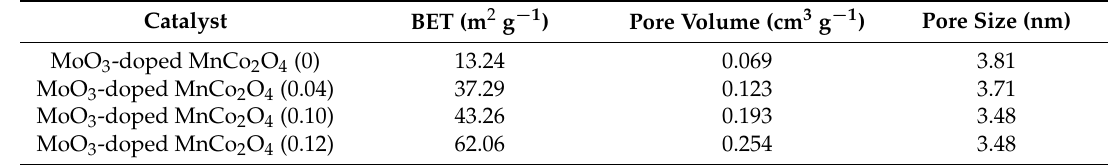
Table 1. Brunauer–Emmett–Teller (BET) surface areas of different samples. Table 1. Brunauer – Emmett – Teller (BET) surface areas of different samples.